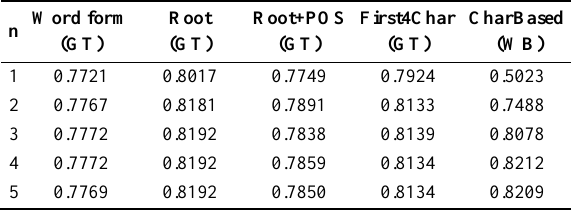
Table 6. Best performances of different language model